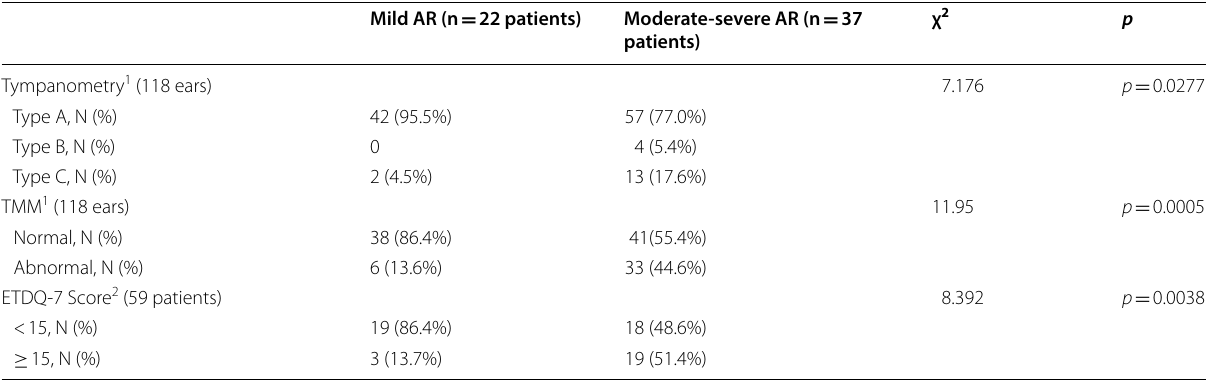
1 Statistical analysis was performed by the number of ears 2 Statistical analysis was performed by the number of patients TMM tubomanometry, ETDQ-7 seven-item Eustachian Tube Dysfunction